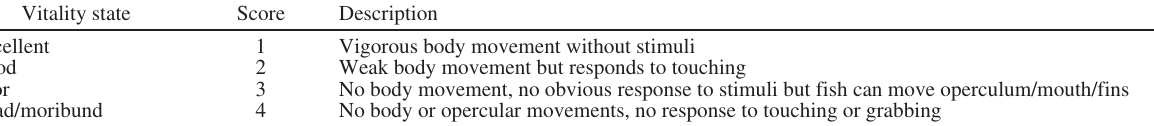
Table 1. – Vitality states/scores with descriptions of qualifying criteria (adapted from Benoît et al. 2010). Vitality state